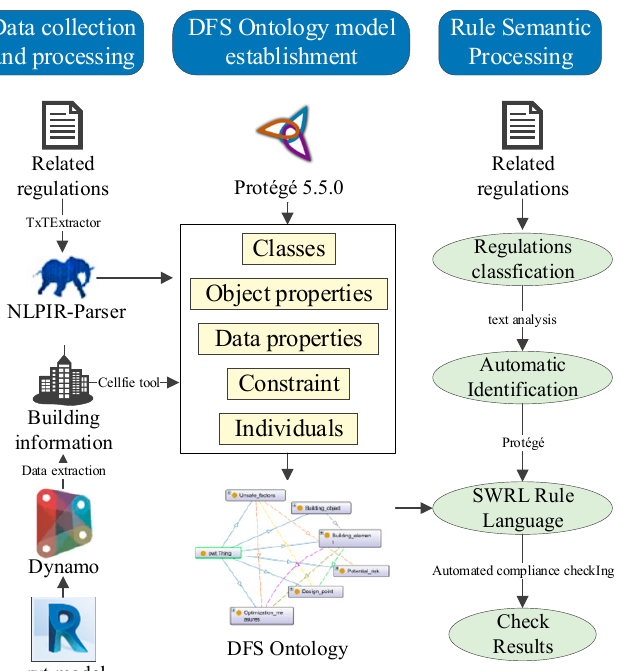
Figure 1. Proposed framework for the development of design for safety (DFS) ontology and auto- mated compliance checking (ACC) rules based on natural language processing (NLP).